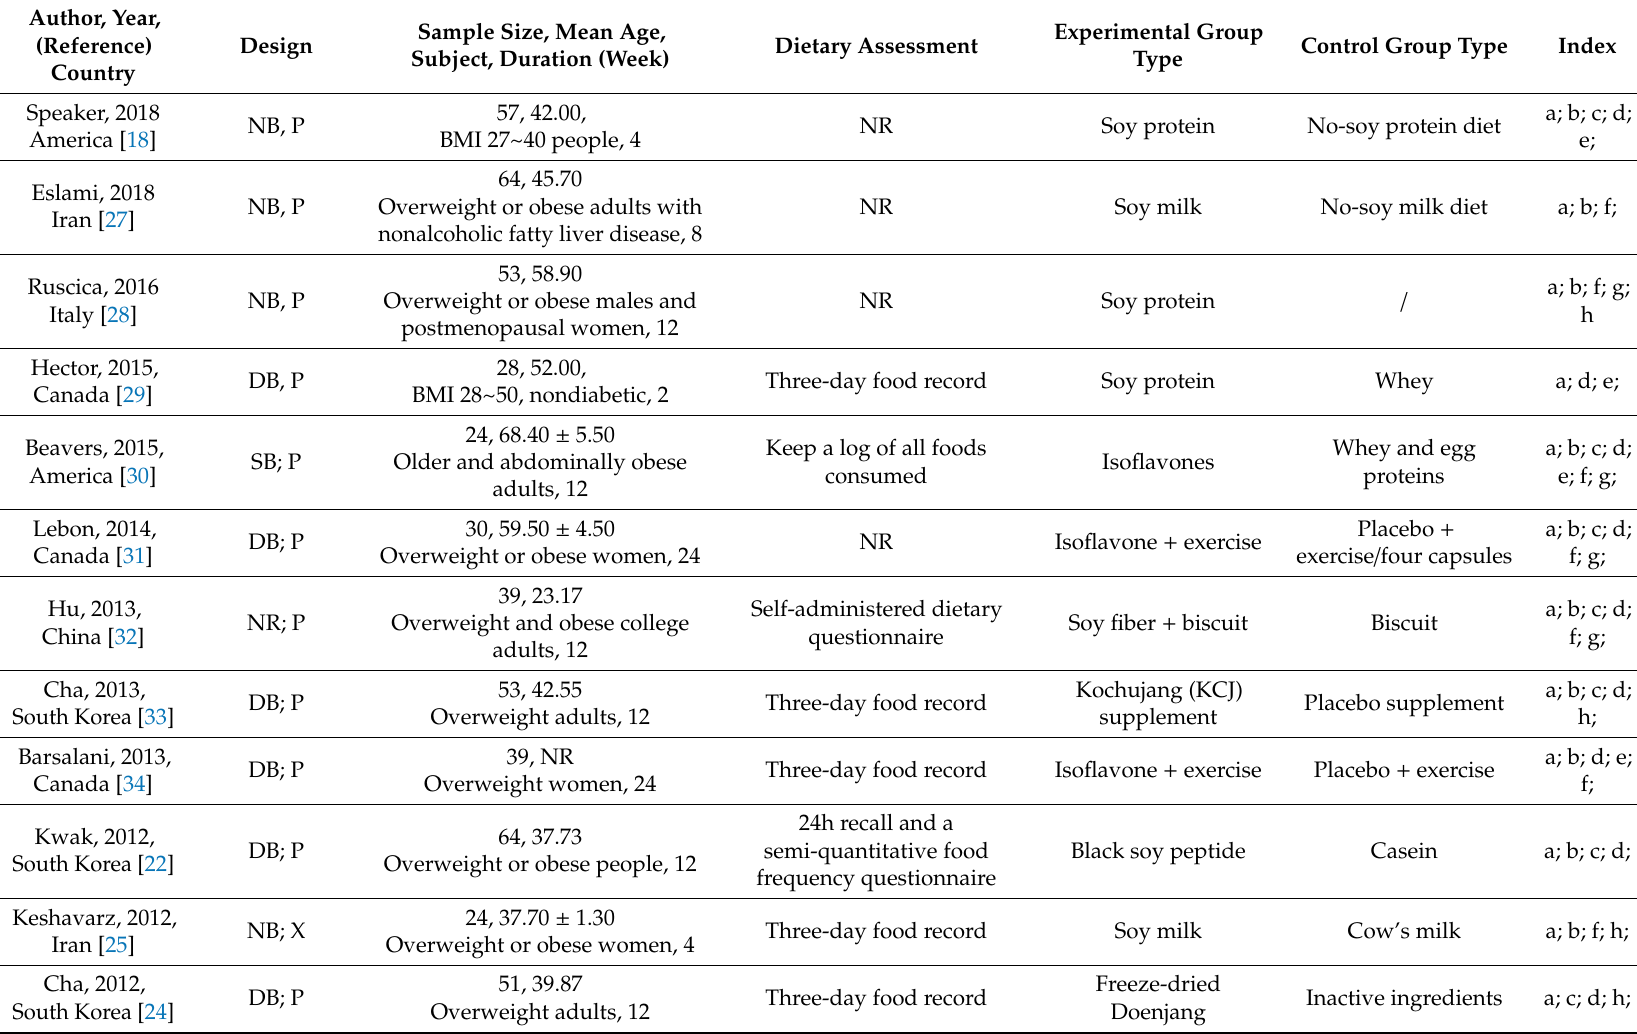
Table 2. Characteristics of all trials included in the present